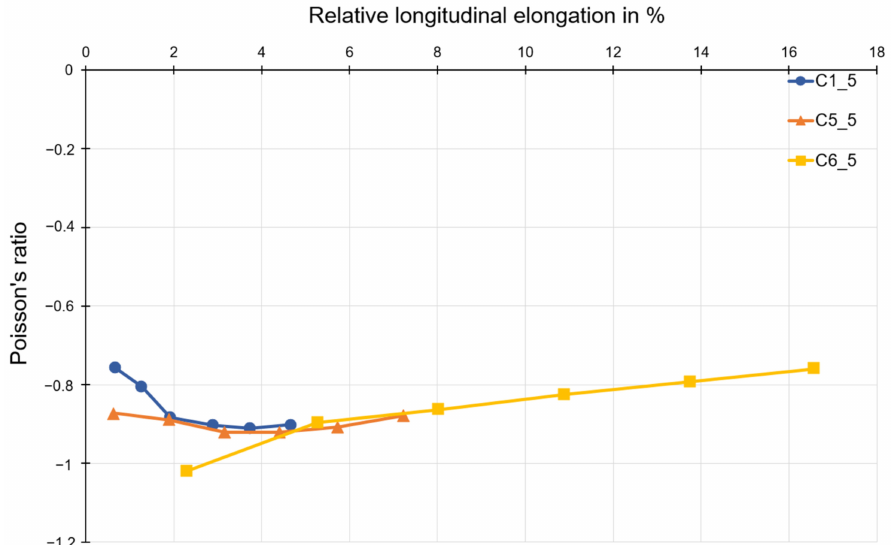
Figure 15. Poisson’s ratio as a function of longitudinal strain for test specimens with 5 × 5 honeycombs.